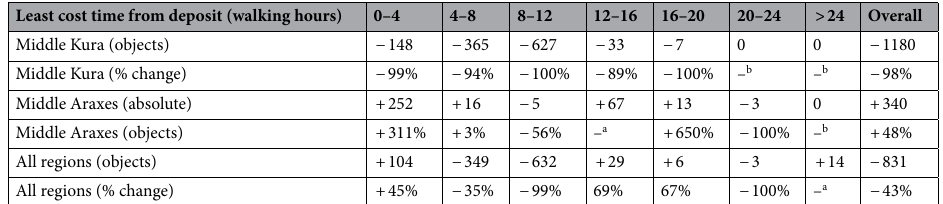
Table 1. Change in gold quantities between the periods 2500–1500 BC and 1500–800 BC among sites at different least cost distances from gold deposits for the Middle Kura zone, Middle Araxes zones, as well as the entire database, expressed as both absolute and relative (%) change. Note that for both zones, distance from deposit has no bearing on the relative change, but the patterns differ strongly between regions. a Percent change is undefined (effectively infinite) because number of objects from 2500–1500 BC is 0. b Percent change undefined because number of objects from both 2500–1500 BC and 1500–800 BC is